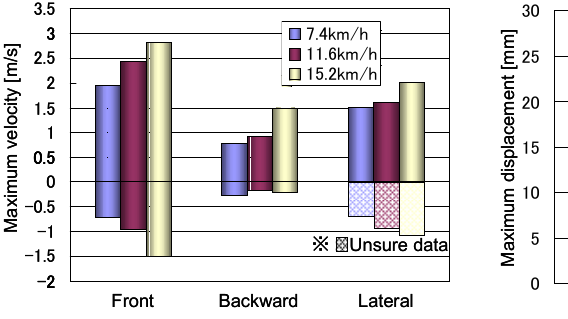
Fig. 10 Comparison of positive maximum displacement for impacts at 7.4, 11.6, and 15.2 [km/h] for each impact direction.